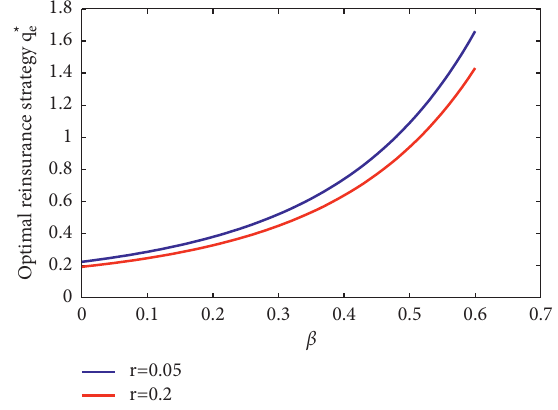
Figure 6: The effects of β on q ∗